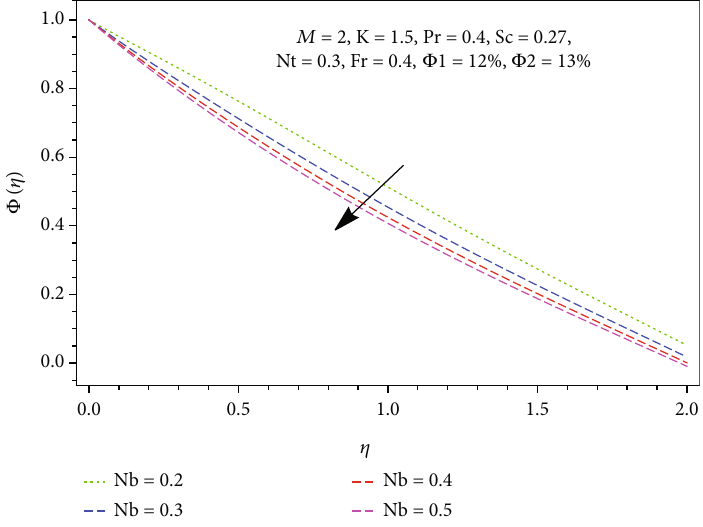
Figure 10: Impact of Brownian motion parameter Nb over concentration pro fi le ϕ ð η Þ .